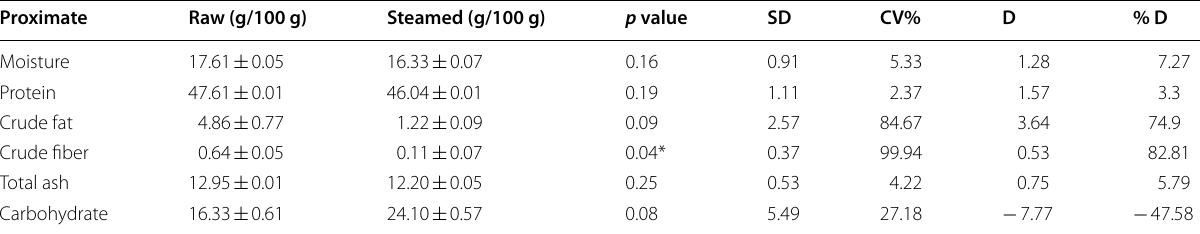
Table 1 Percentage proximate composition in raw and steamed flesh of African Mud Creeper, T. fuscatus var radula